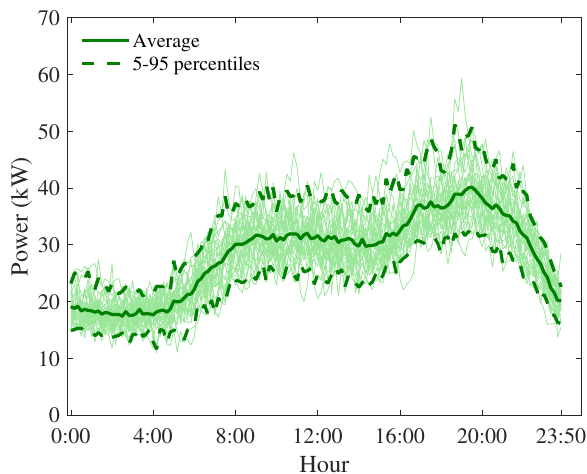
Figure 7. Case study: aggregated residential demand.